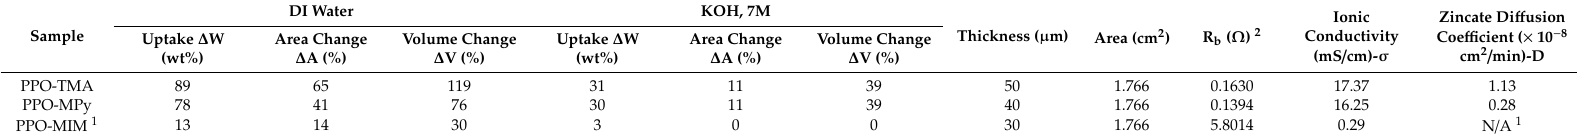
Table 1. Basic properties of PPO-TMA, PPO-MPy, and PPO-MIM separator